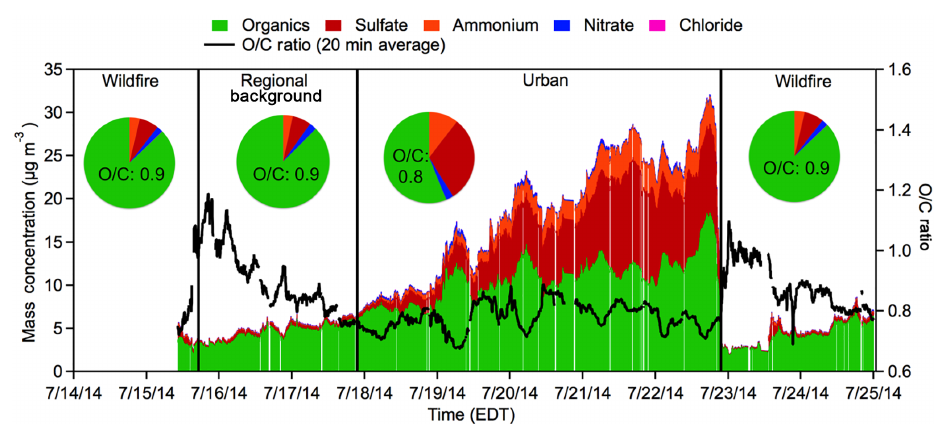
Figure 3. PM 1 non-refractory chemically speciated mass concentrations, as well as O / C ratios (20min averages), measured with the HR- AMS. Periods of influence are notated and separated by solid vertical lines. Pie charts represent the average mass fractions for each air mass period, with average O / C ratio inset.